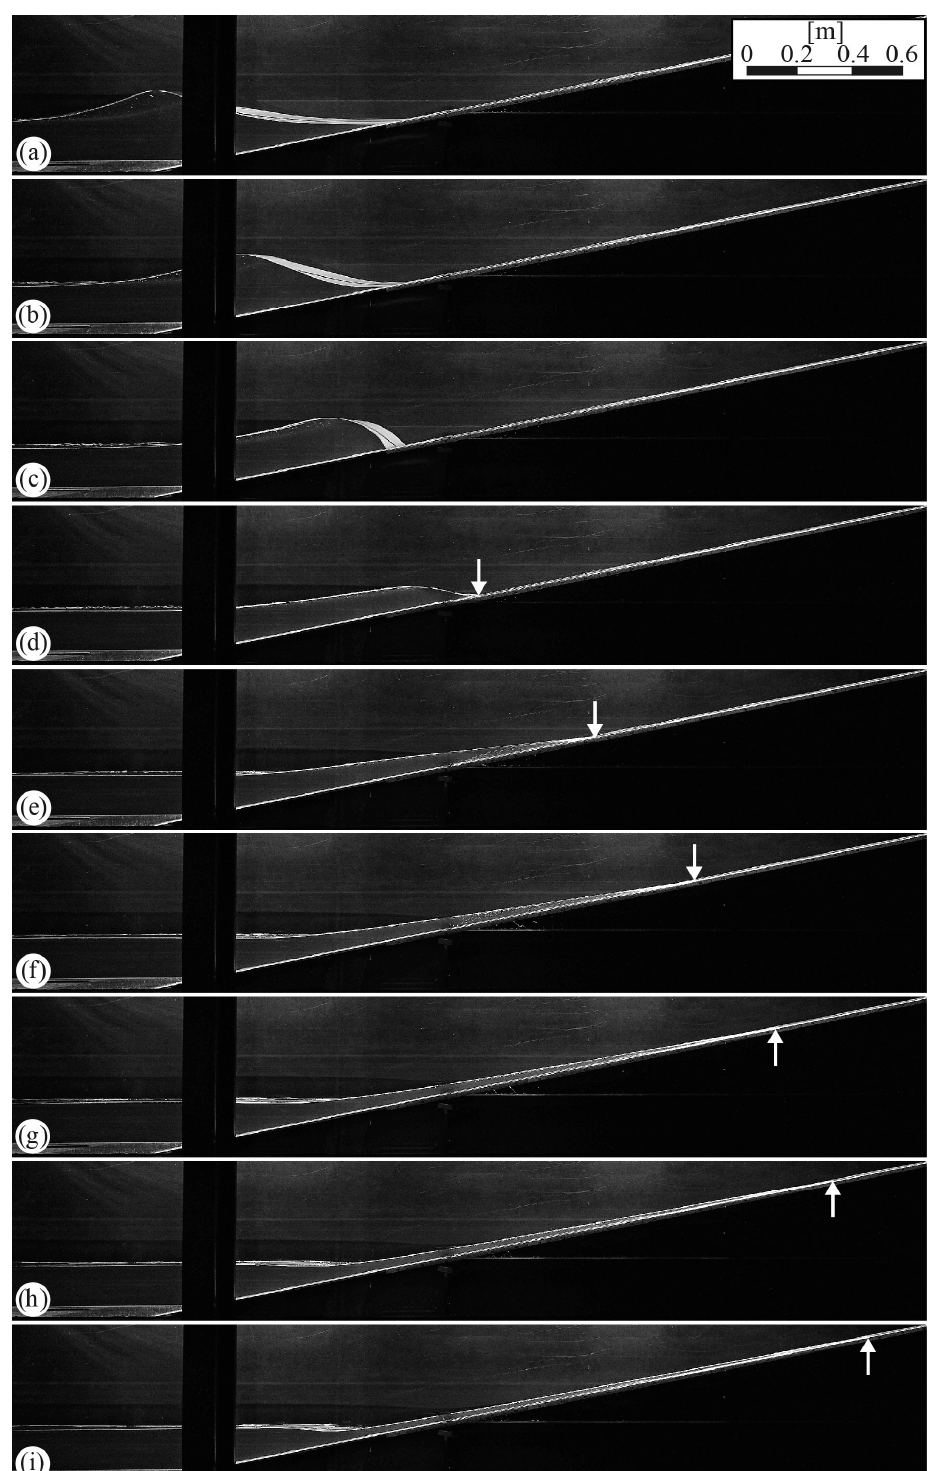
Figure 4. Solitary wave runup for tan β = 1/5.0 ( β ≈ 11.3°), ε = 0.69, and S o = 0.37, time increment between images Δ t = 0.2 s, flow front indicated by arrow (reproduced from Fuchs [20]). Maxworthy [19] studied solitary wave reflection at a vertical wall as well as head‐on collision between two solitary waves in a 5 m long, 0.2 m wide, and 0.3 m deep channel. Only runup data at the wall was considered for this study. The waves were generated manually by pulling a plate through the channel. The wave characteristics and the runup height were measured optically. The runup data by Maxworthy [19] was extracted with WebPlotDigitizer [25] from the original publication. The number of experiments included from Maxworthy [19] is n = 14.